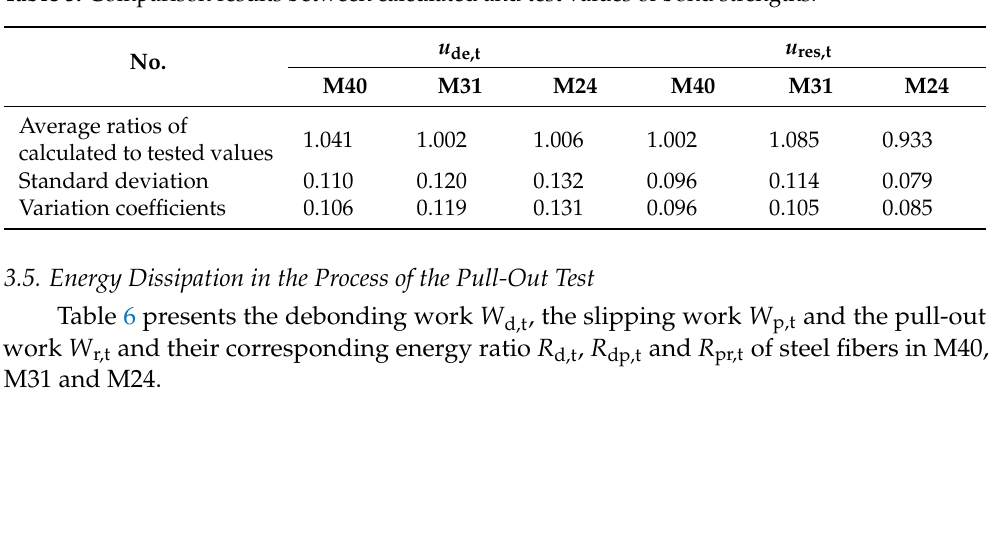
Curing Age (days)